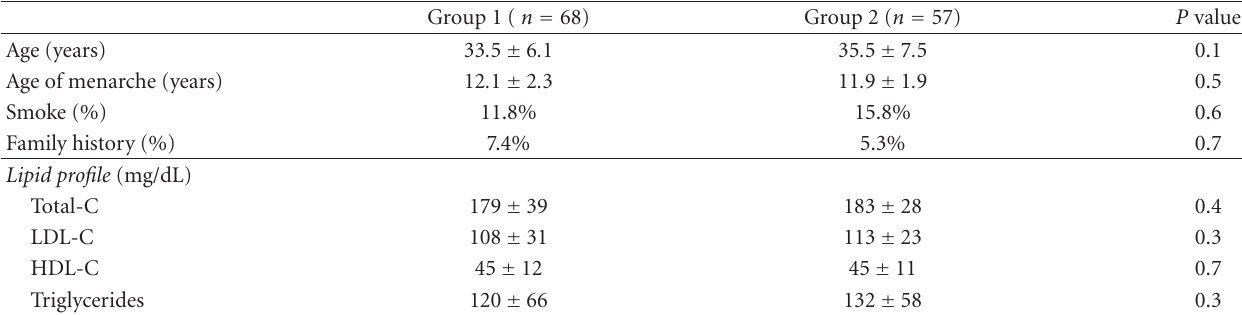
Table 1: The clinical and demographic characteristics of study